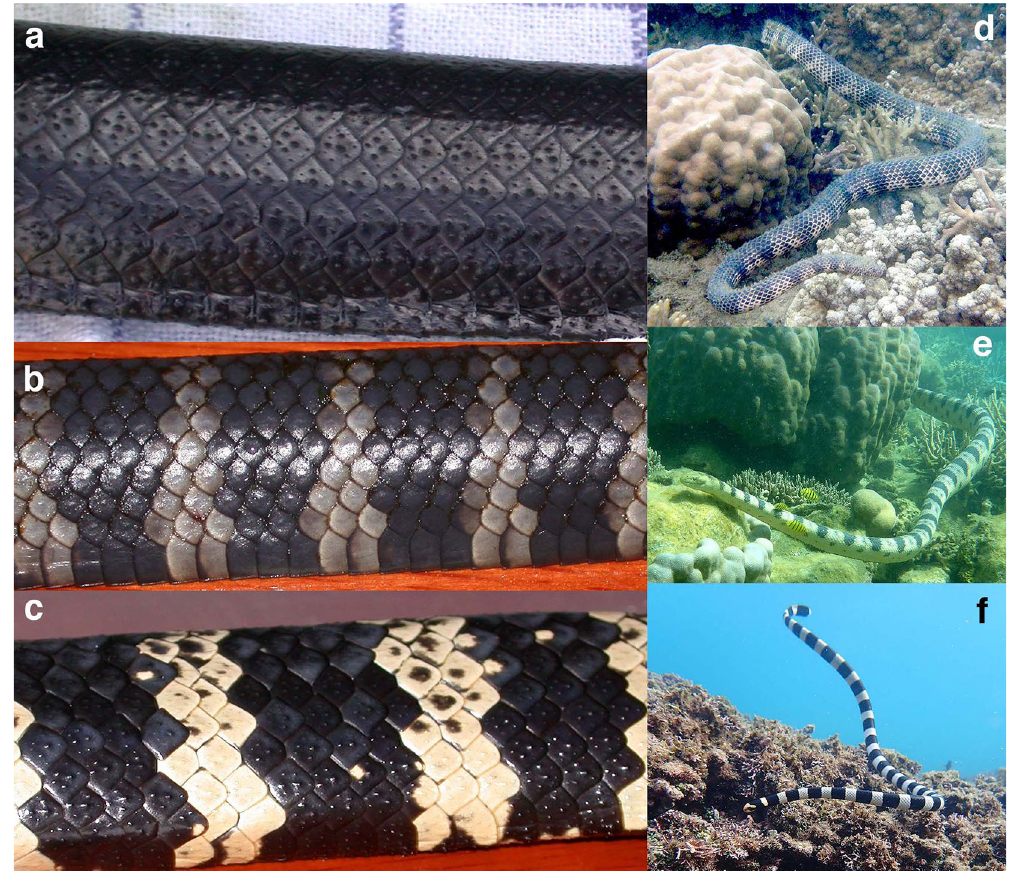
Figure 1. Photographs of colour morphs in turtle-headed sea snakes, Emydocephalus annulatus , and putative models that may be mimicked by the banded morphs. Left-hand panels show ( a ) melanic, ( b ) intermediate, and ( c ) black-and-white banded specimens of E. annulatus . Right-hand panels show the putative models for banded morphs ( d ) Aipysurus duboisii , ( e ) Hydrophis major , and ( f ) Laticauda saintgironsi . Photographs by R. Shine except for H. major and L. saintgironsi (C.